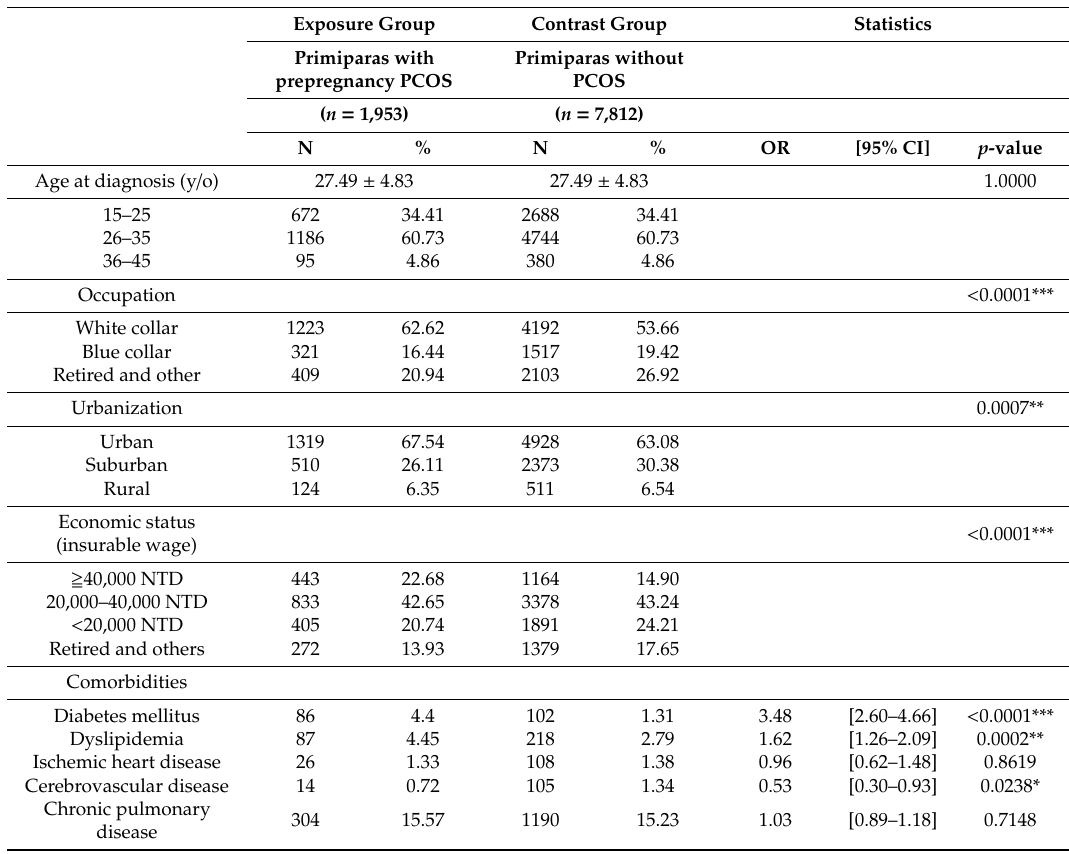
Table 1. Comparisons of the characteristics between the exposure (prepregnancy PCOS) and contrast (no PCOS)